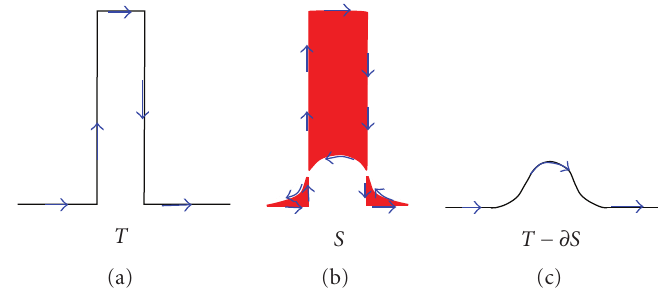
Figure A.2. Example flat norm decomposition. T is the 1-current we are computing the flat norm of, and S gives the optimal decomposition into S and T − ∂S . Finally, the flat norm is simply M ( S )+ M ( T − ∂S ) = length of the right-most curve and area of the red region.